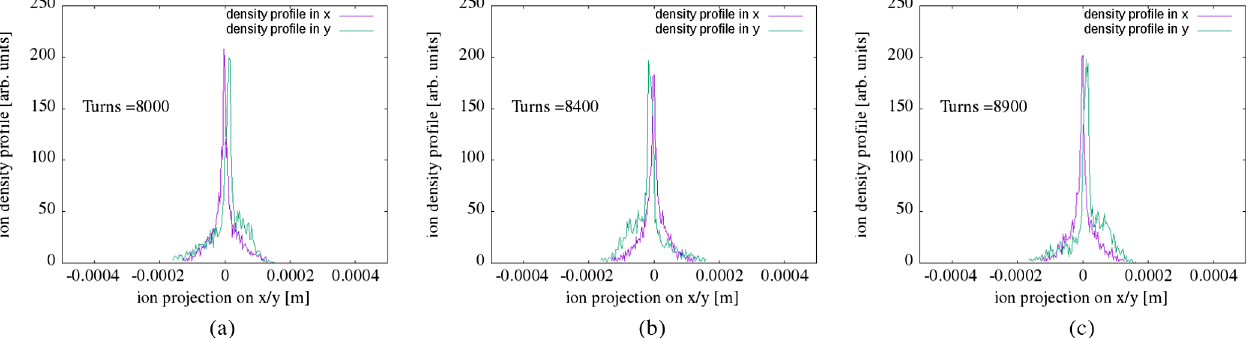
FIG. 7. Ion density profile sampled at the 8000th, 8400th, and 8900th turns (from left to right). The ion density profiles deviate from the Gaussian type and form a higher-density peak in the center. The density profile in the vertical direction shows an oscillation due to the beam-ion interaction. The simulation is launched with strong-strong model and takes synchrotron radiation damping and quantum excitation into account.